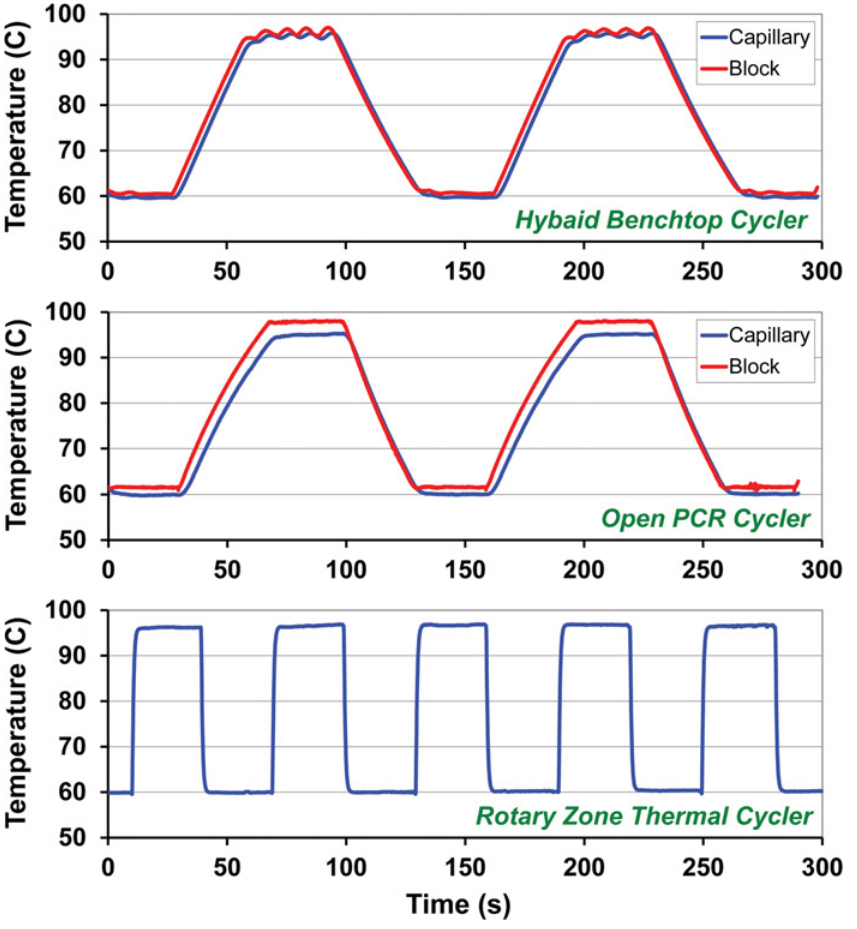
Fig 7. Thermal cycling performance comparison for three thermal cycler designs between 60°C and 96°C. Conventional Peltier based bench-top and hybrid Peltier/forced air OpenPCR thermal cyclers display significantly slower temperature ramp rates than those obtained by the stepper motor actuation of the